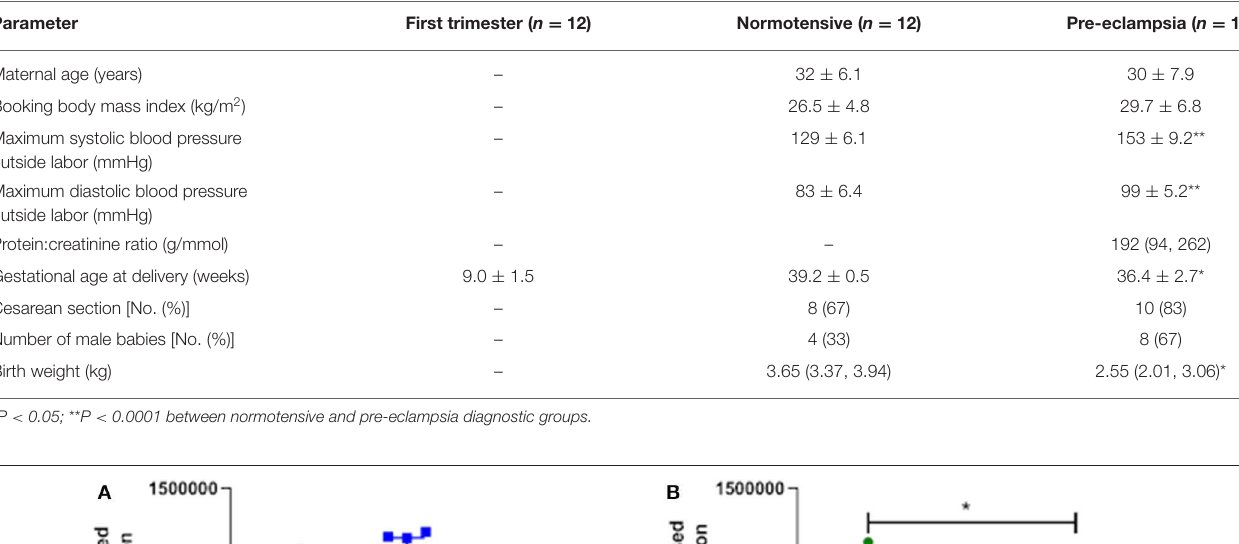
TABLE 1 | Demographic, clinical, and biochemical data of participants.